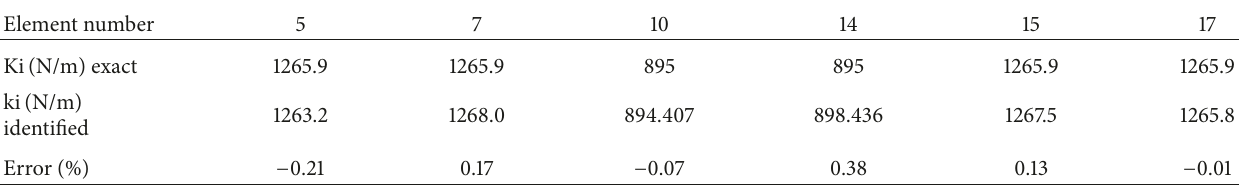
Table 1: Comparisons of identified element stiffness parameters of the